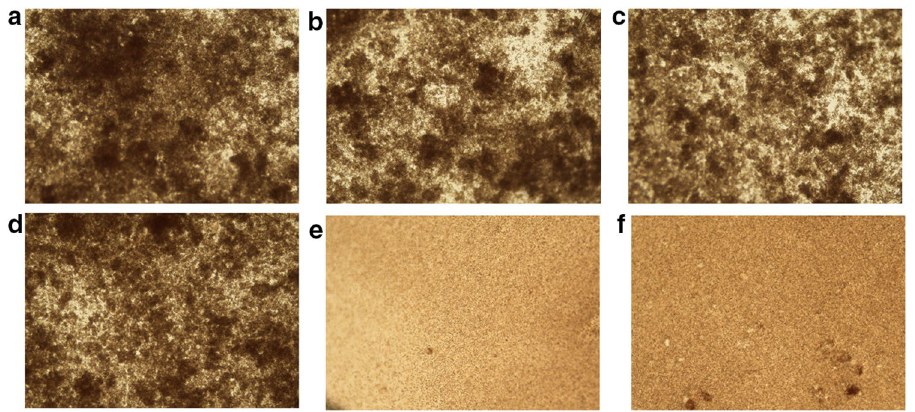
Figure 4. Haemagglutination analysis. Erythrocyte’s agglutination tests of the CFT073, Cri-dots-papG, and K12 in presence ( +) and absence of mannose ( −). Upper panel shows without mannose treatment ( a – c ) and lower panel with mannose treatment ( d – f ). ( a , d ) CFT073, ( b , e ) Cri-dots-papG and ( c , f )